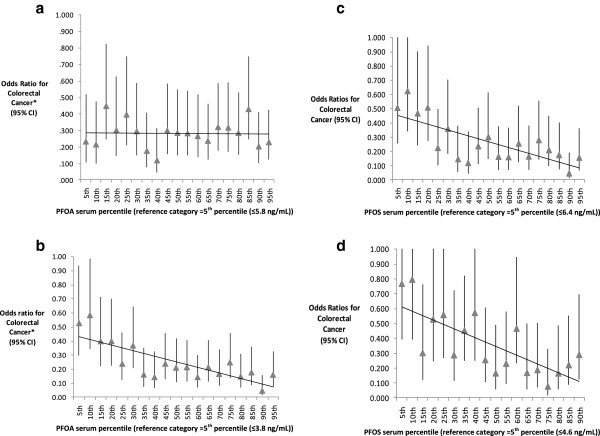
Association of serum PFOA and PFOS levels to likelihood of colorectal cancer diagnosis. a. All eligible participants (N=208 CRC cases, 47,151 controls). b. Sample restricted to those with PFOA serum values ≤ 20 ng/mL (N=84 CRC cases, 19,117 controls). c. All eligible participants (N=208 CRC cases, 47,151 controls). d. Sample restricted to those with PFOS serum values ≤ 20 ng/mL (N=118 CRC Cases, 23,287 Controls).